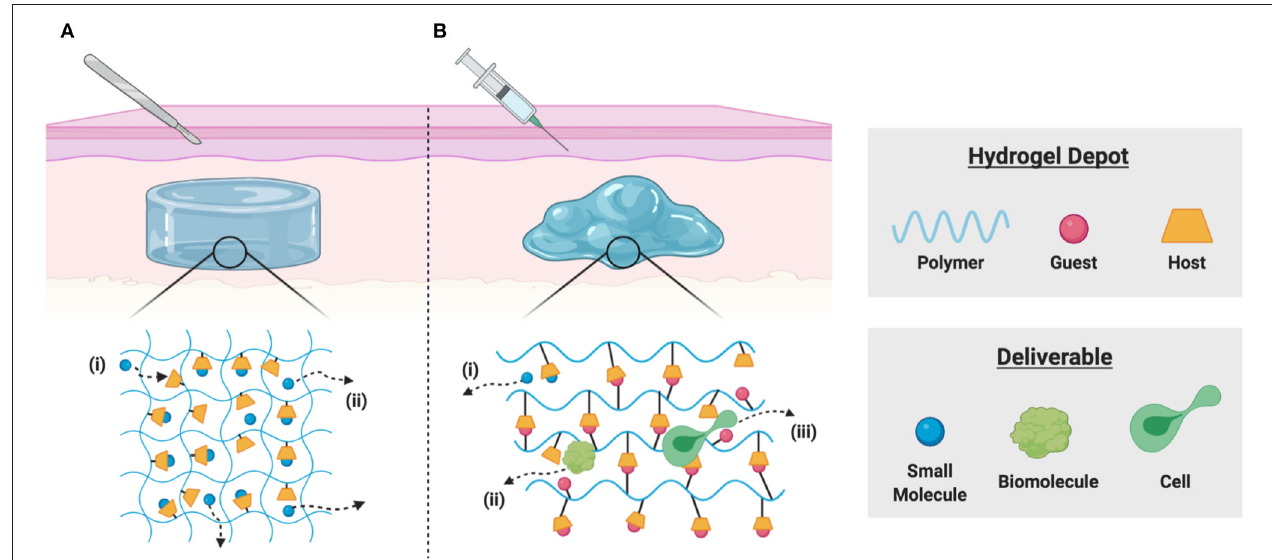
FIGURE 2 | Schematic representation of local delivery from implantable and injectable hydrogels. (A) Polymer-bound macrocycles form inclusion complexes with desired deliverables in implantable hydrogels, allowing for (i) sequestration of drugs through guest-host complexation and (ii) affinity-based release by diffusion of unbound drug molecules. (B) Polymer-bound host macrocycles can form reversible physical bonds with hydrophobic guest molecules, allowing for the formulation of dynamic supramolecular crosslinks. These shear-thinning and injectable materials enable (i) drug sequestration through guest-host affinity, (ii) diffusive release of soluble biomolecules, and (iii) dynamic bond rearrangement necessary for cell migration into or out of the